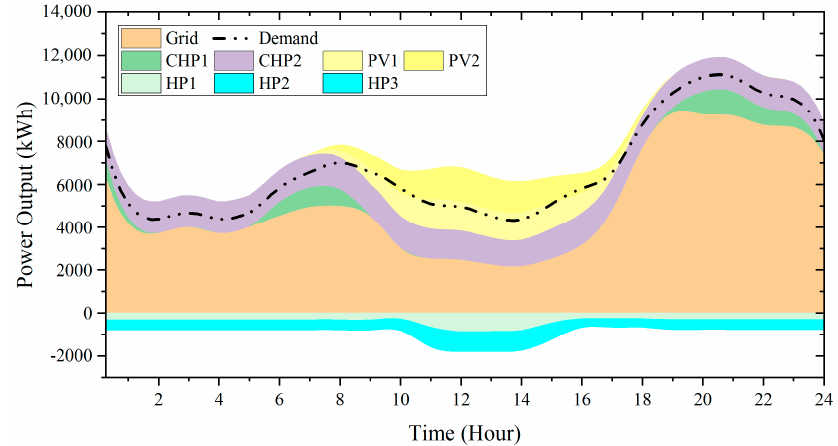
Figure 7. Power output of local sources.